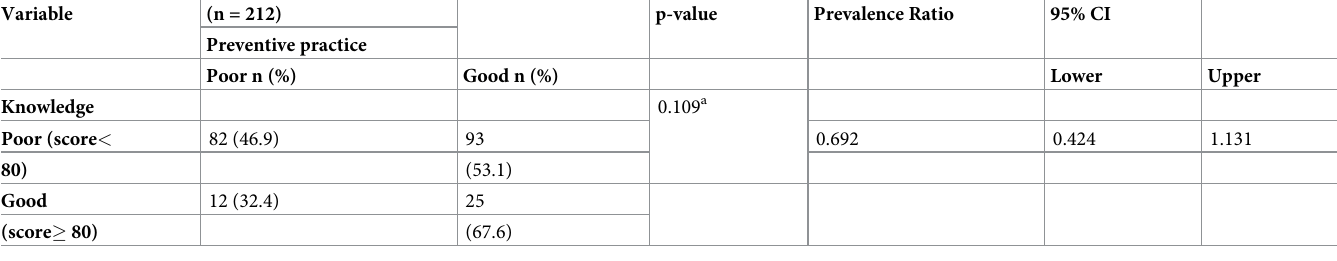
Table 9. Association between knowledge with the preventive practice of food poisoning among the respondents. Variable (n =